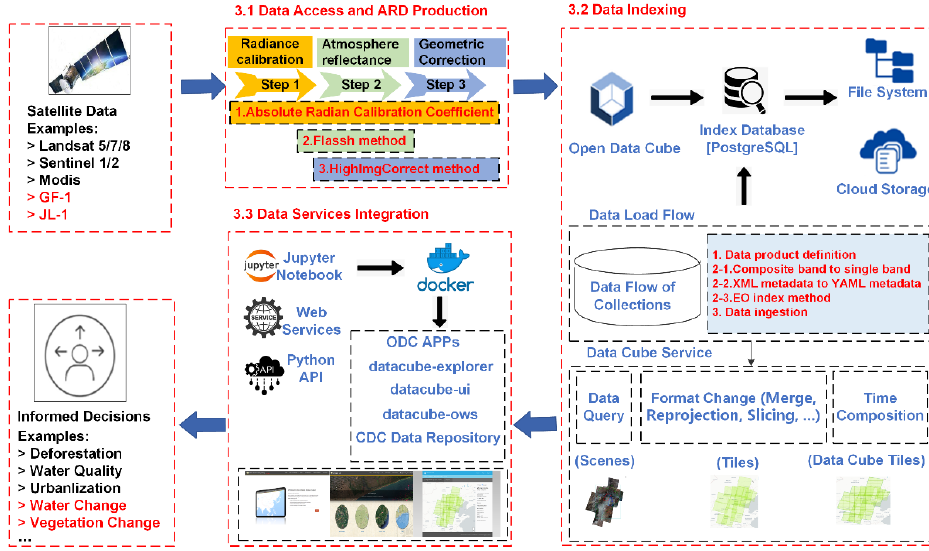
Figure 1. China Data Cube (CDC) architecture diagram.